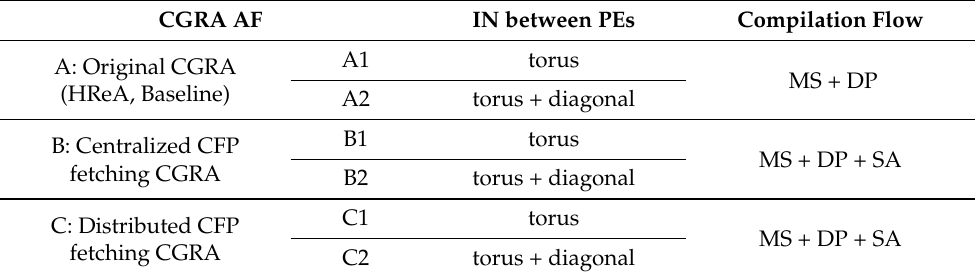
Table 2. Different configurations of CGRA architecture and compilation